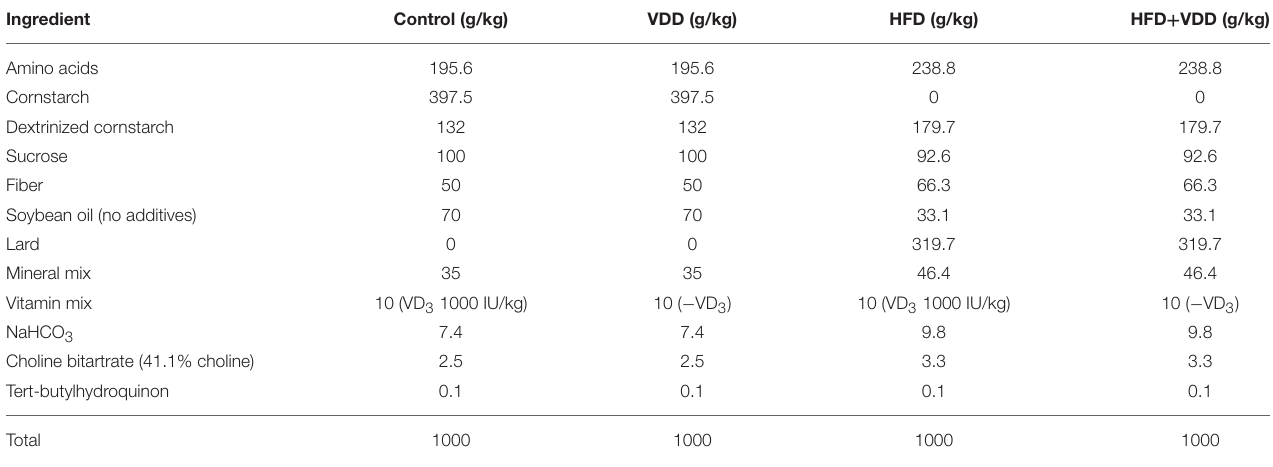
TABLE 1 | Composition of four types of diet used in the study. Ingredient Amino acids Cornstarch